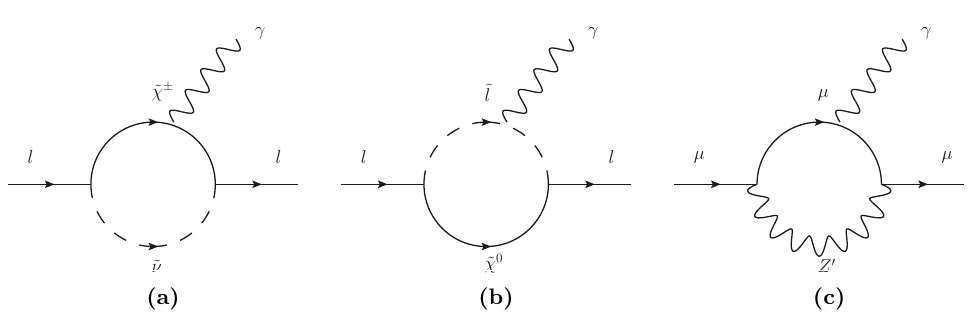
Figure 1. Figures 1(a) and 1(b) constitute the SUSY contribution to general lepton magnetic moments. Figure 1(c) contributes solely to the anomalous magnetic moment of the